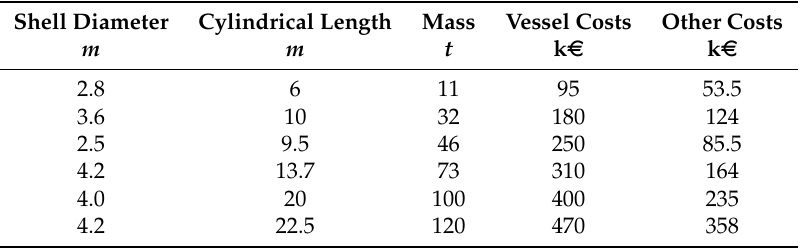
Table 2. Practical experience cost factors for classical Ruths steam storage